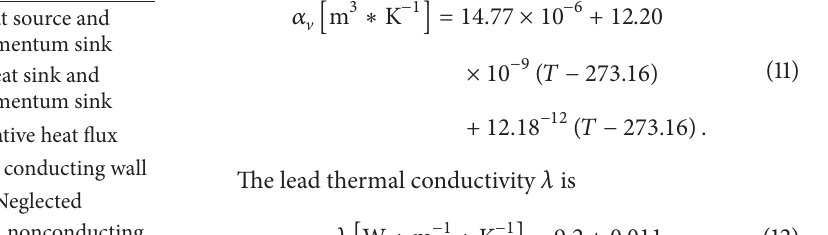
Table 3: CFD model boundary conditions. Sl. number